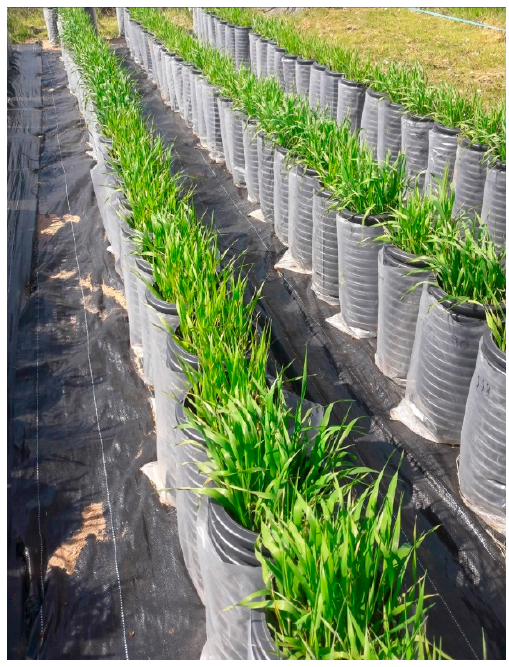
Figure A4. Photo of spring barley growing outside.